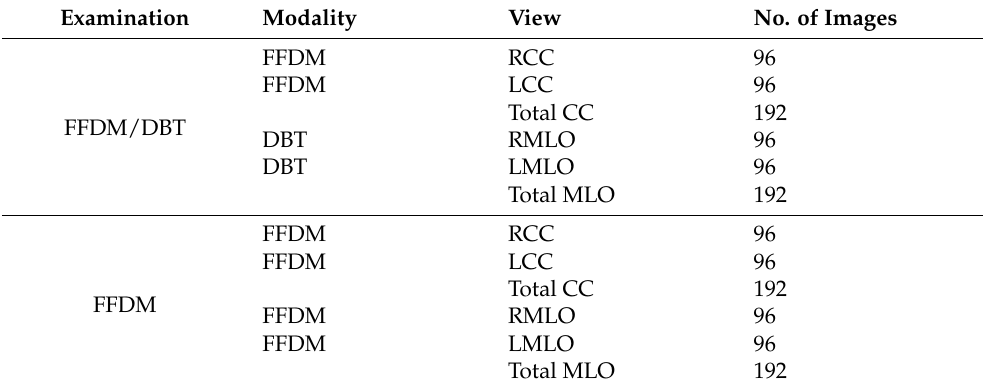
Table 1. Number of images per each view and modality used in this